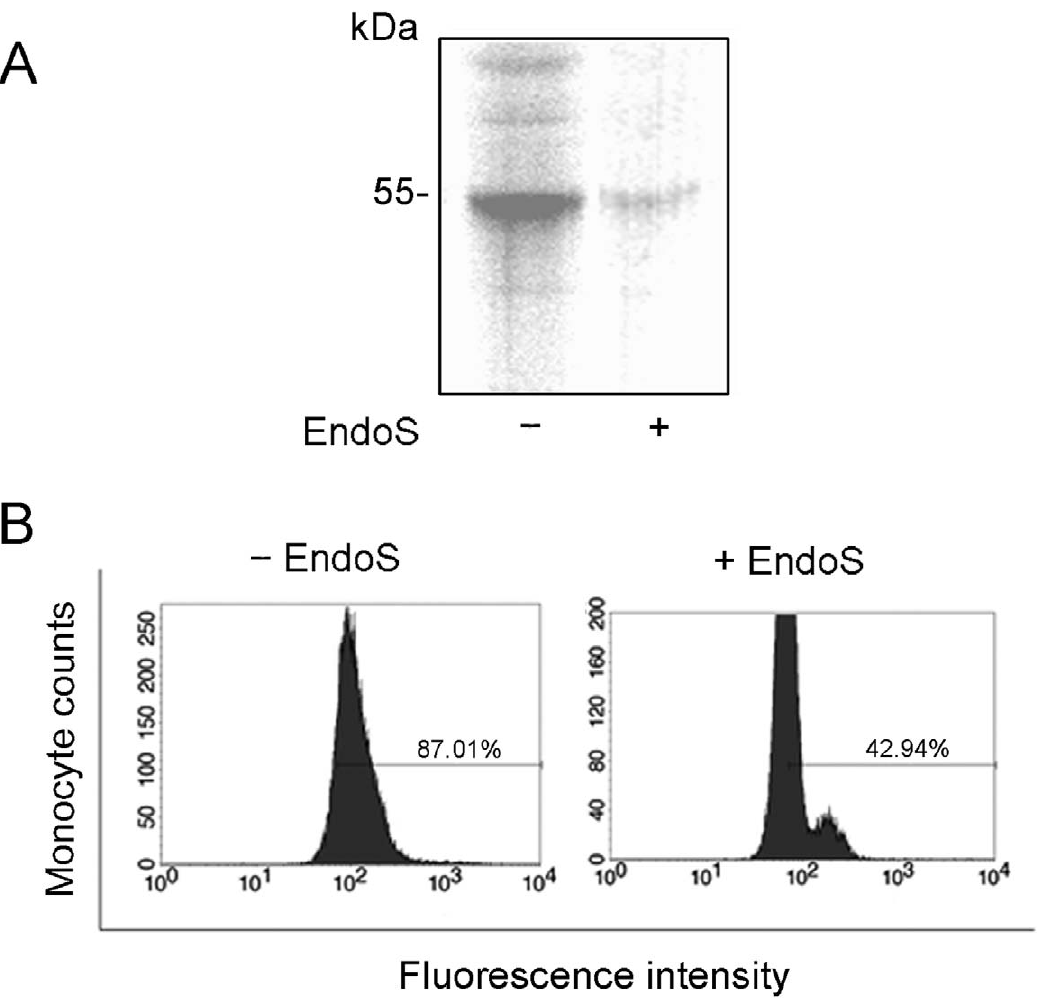
Figure 6. EndoS treated IgG does not bind to monocytes. Panel A. Monocytes were incubated with 125 iodine-labelled IgG (intact or EndoS-treated). After incubation for 30 minutes at room temperature, the proteins from cell lysates, 10 m g total protein, were separated by 10% SDS-PAGE. The gel was dried and analyzed by phosphorimaging. Panel B. Flow cytometry analysis showing the decreased binding of IgG to activated monocytes in blood treated with EndoS. Human blood was treated with EndoS before addition of leukocyte activator fMLP. The IgG binding to monocytes was detected using mouse anti-human IgG and FITC-labelled goat anti-mouse IgG as a secondary antibody.